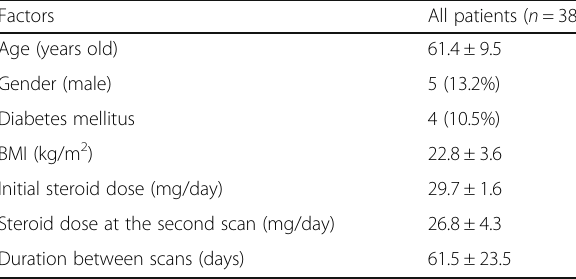
Table 2 Characteristics of included